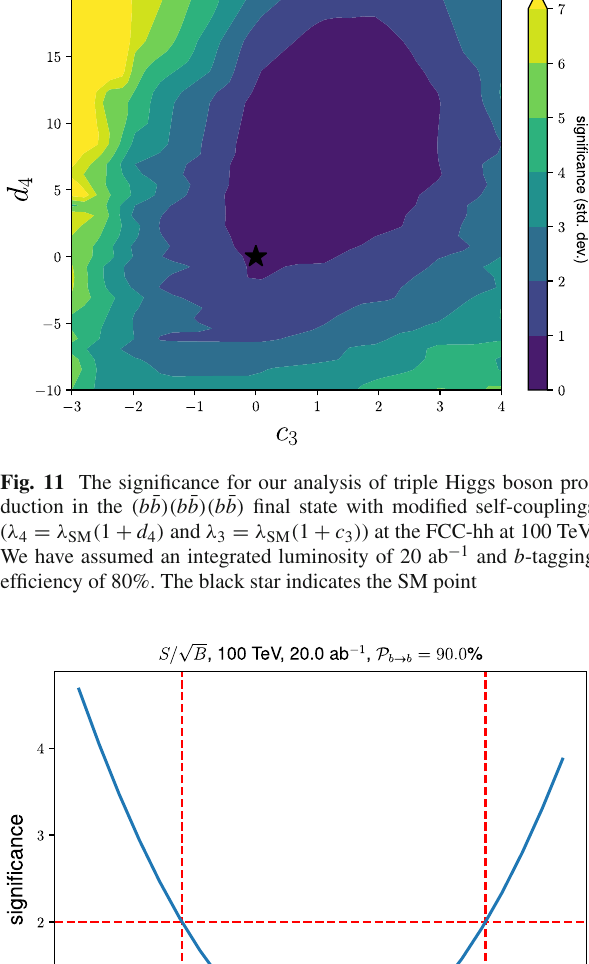
ground processes, we would obtain ∼ 4 . 3 × 10 4